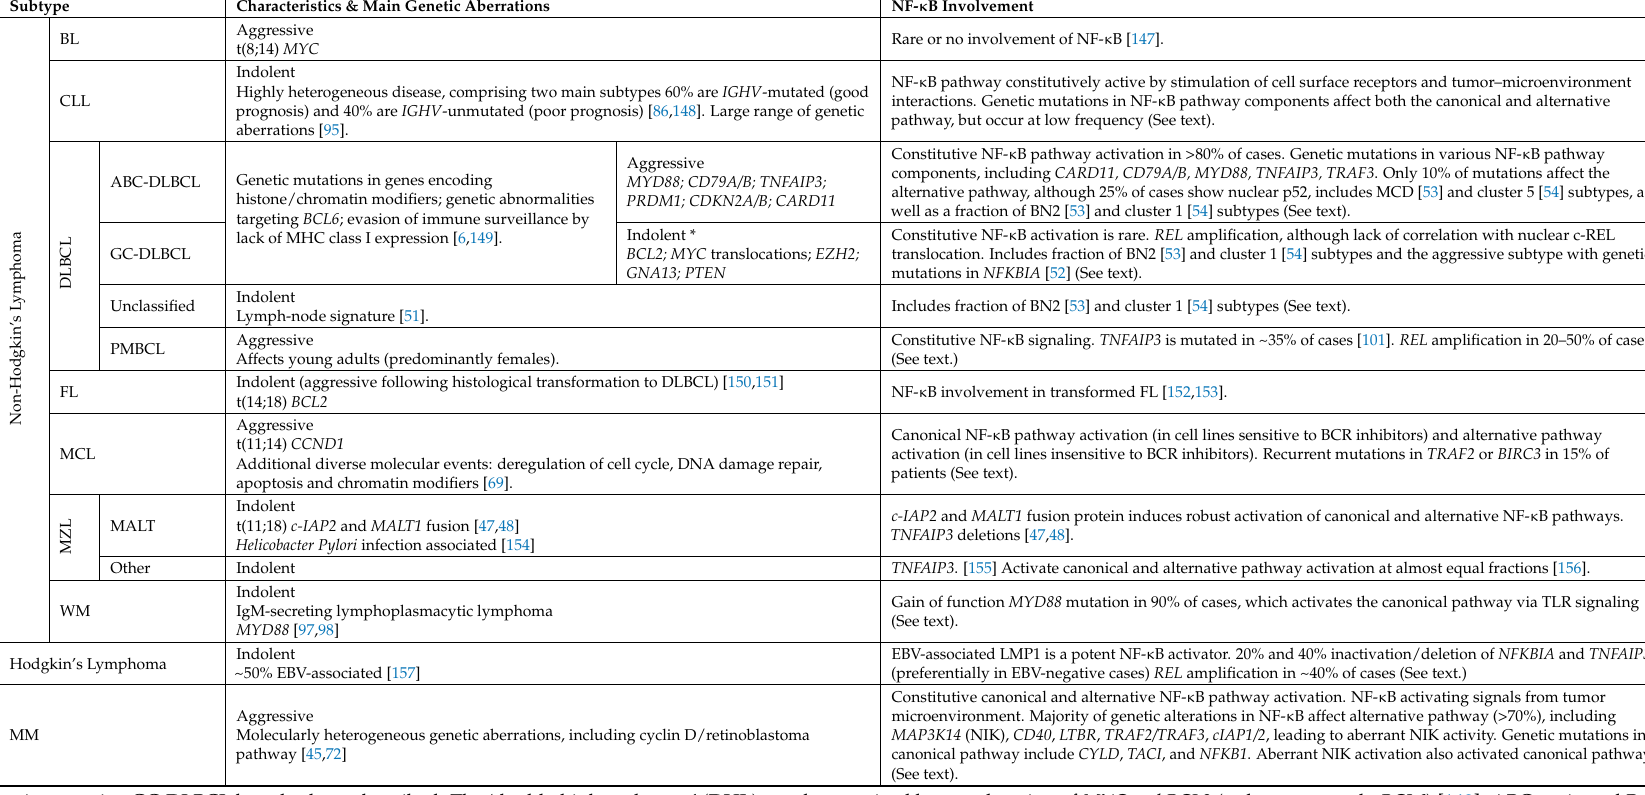
Table 1. Characteristics of lymphoma subtypes and NF- κ B